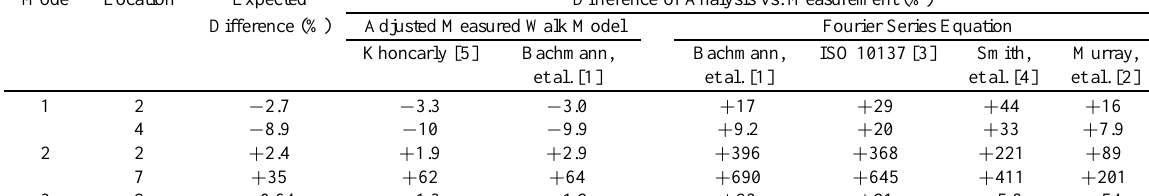
Table 2 Comparison of the responses from the computer analysis vs. measurements for different walk forcing functions at different resonance step